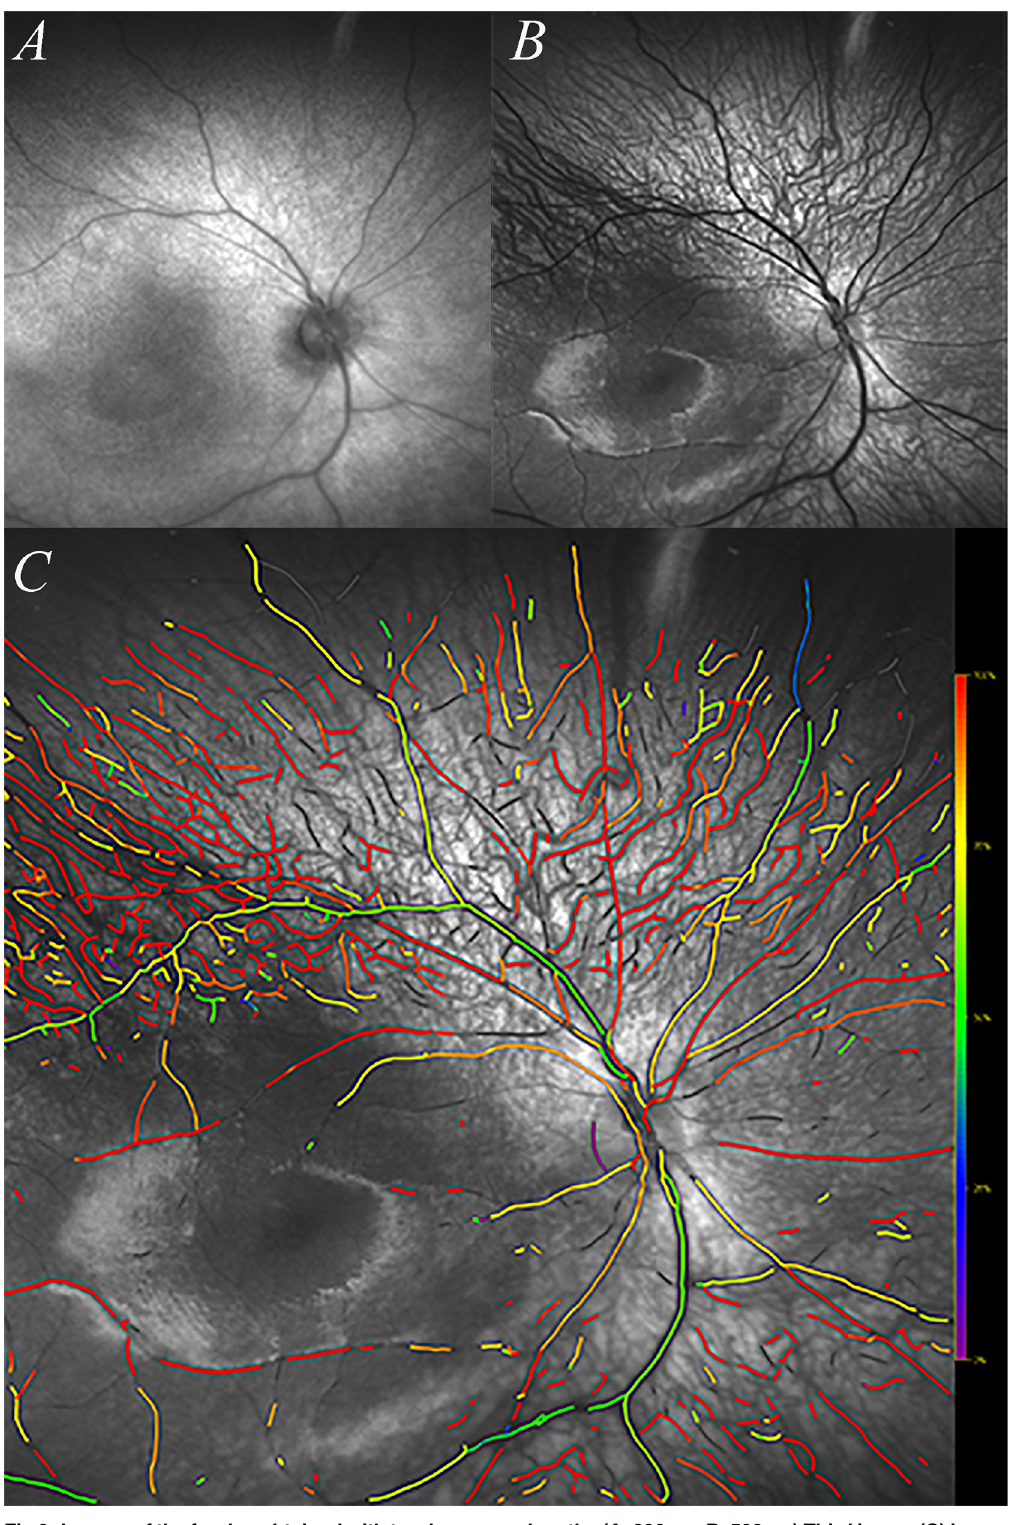
Fig 2. Images of the fundus obtained with two laser wavelengths (A, 633nm; B, 532nm) Third image (C) is pseudocolor fundus image created by Oxymap algorithm. The colors denote approximate oxygen saturation. However, the calibration is set for an adult population and it is likely that the colors do not represent true oxygen saturation in infants. In addition to the retinal vessels, the vessels of the choroid can be seen in the superotemporal, superonasal and inferior-nasal quadrant doi:10.1371/journal.pone.0148077.g002 PLOS ONE | DOI:10.1371/journal.pone.0148077 February 3,